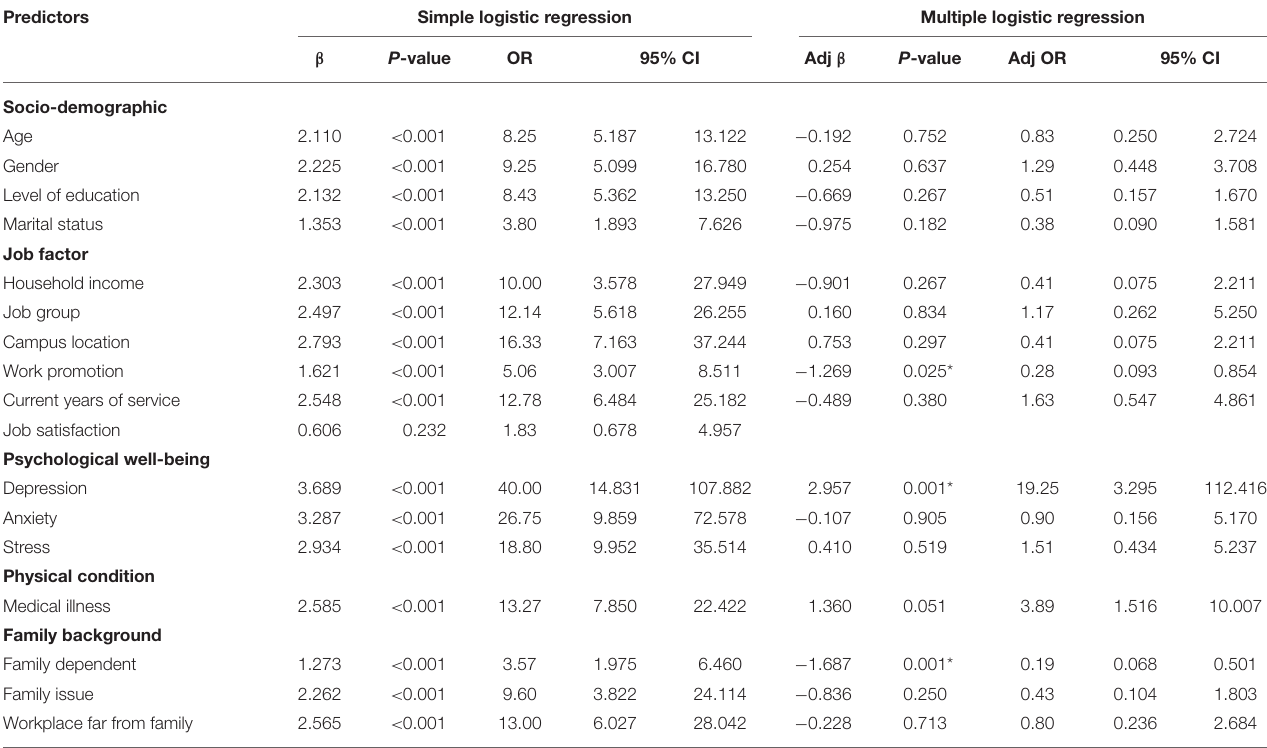
TABLE 3 | Logistic regression analyses for the predictors of WHOQOL-BREF PSY-QOL domain. Predictors Simple logistic